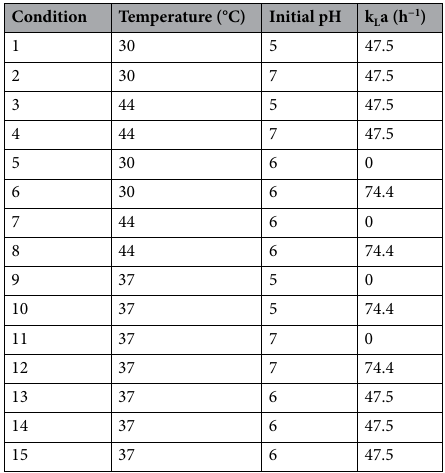
Table 1. Box–Behnken design of experiments generated by MATLAB R2019a using the function bbdesign with three variables and three